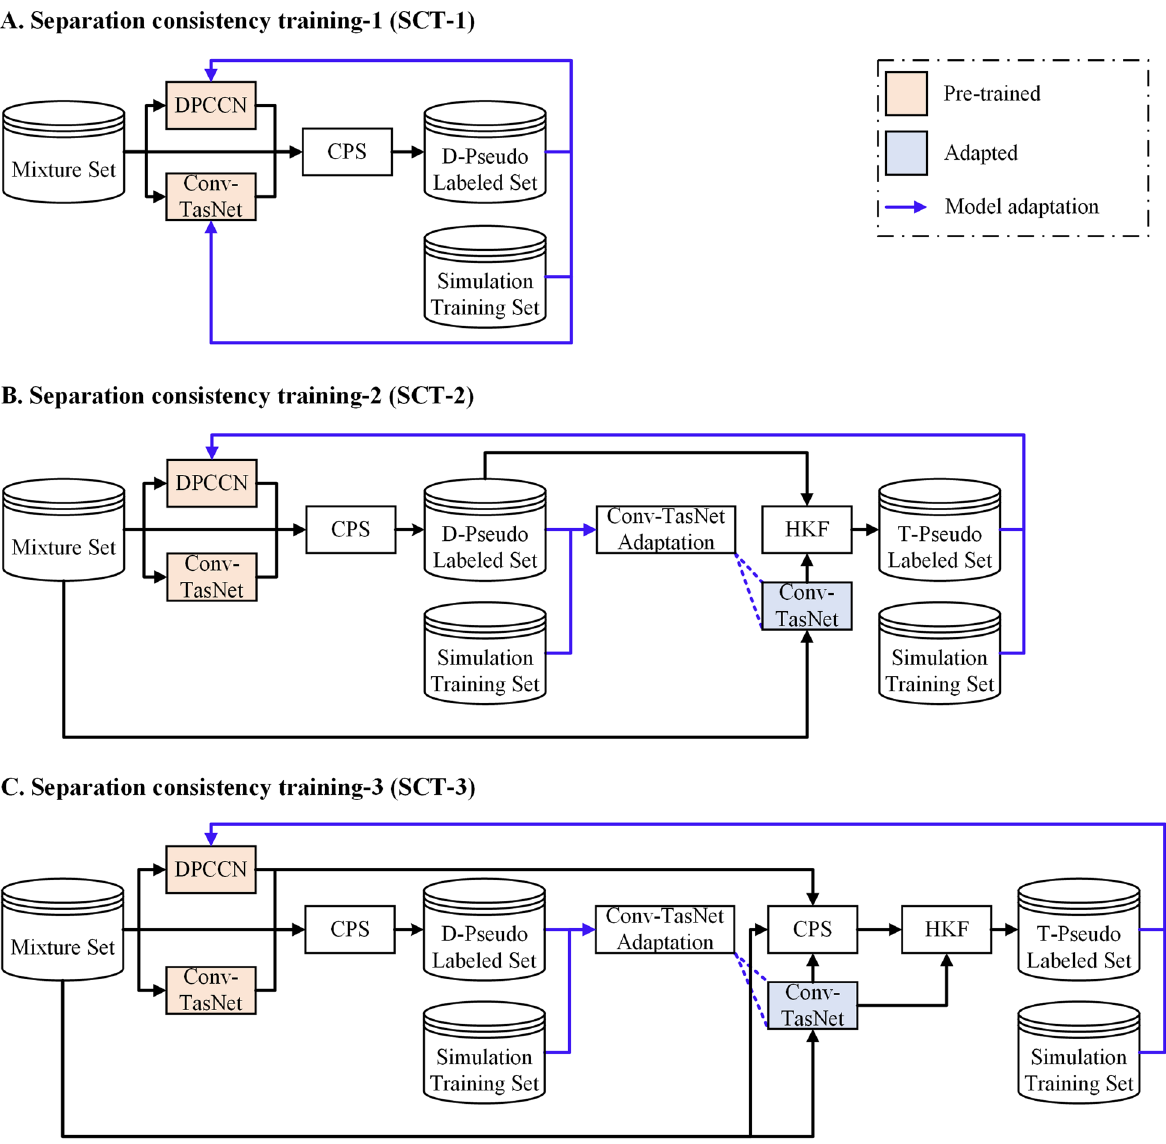
Fig. 1 The flowcharts of three SCT variants for single iteration. A Framework of the 1st SCT variant (SCT-1). The selected DPCCN outputs with pseudo labels are used to update both Conv-TasNet and DPCCN. B Framework of the 2nd SCT variant (SCT-2) with the cross-knowledge adaptation. C Framework of the 3rd SCT variant (SCT-3). Two-stage CPS are used to refine the